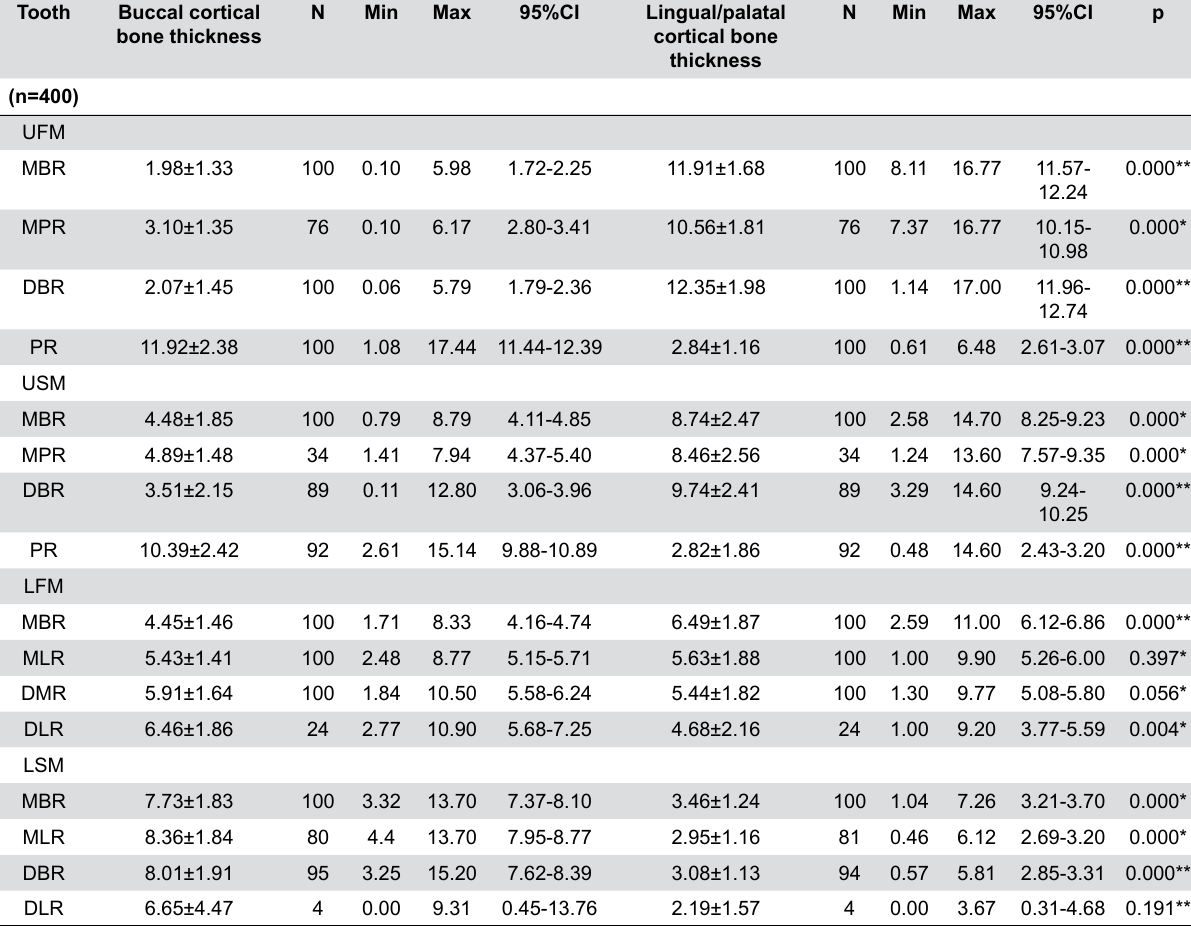
Table 3- Buccal and lingual/palatal bone thickness of maxillary and mandibular posterior teeth a,b, in the coronal